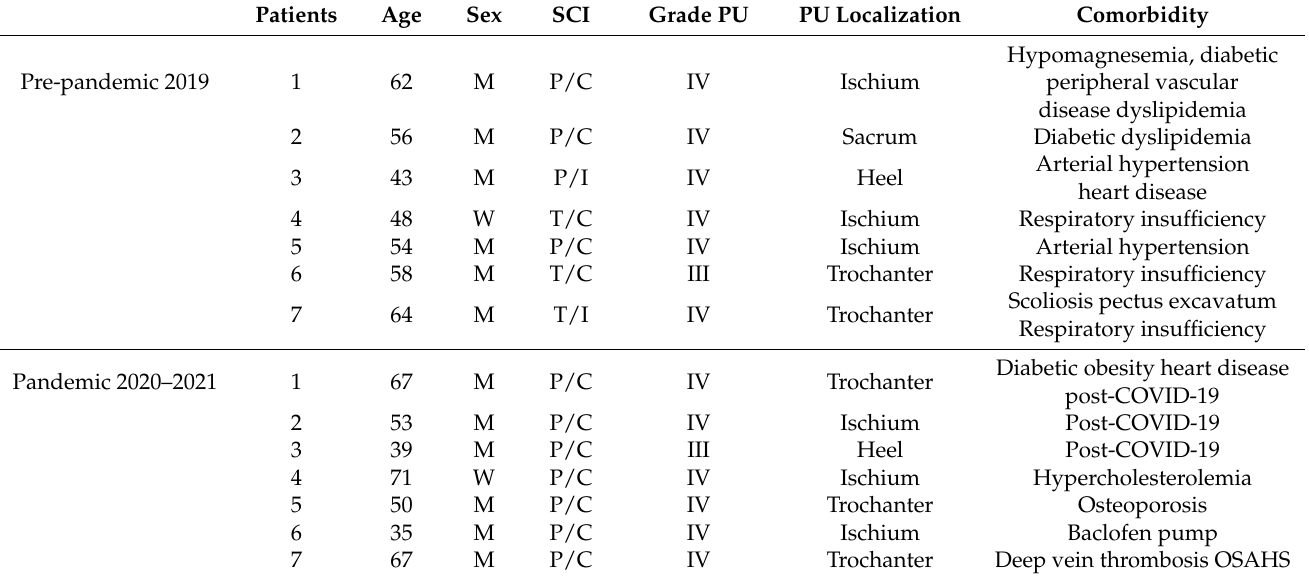
Table 1. Patient information registered included gender, age, SCI type, ulcer characteristics, and comorbidities. Abbreviations: SCI: spinal cord injury; PU: pressure ulcers; M: man; W: woman; P: paraplegic; T: tetraplegic; C: complete; I: incomplete; COVID: coronavirus disease; OSAHS: obstructive sleep apnea hypopnea